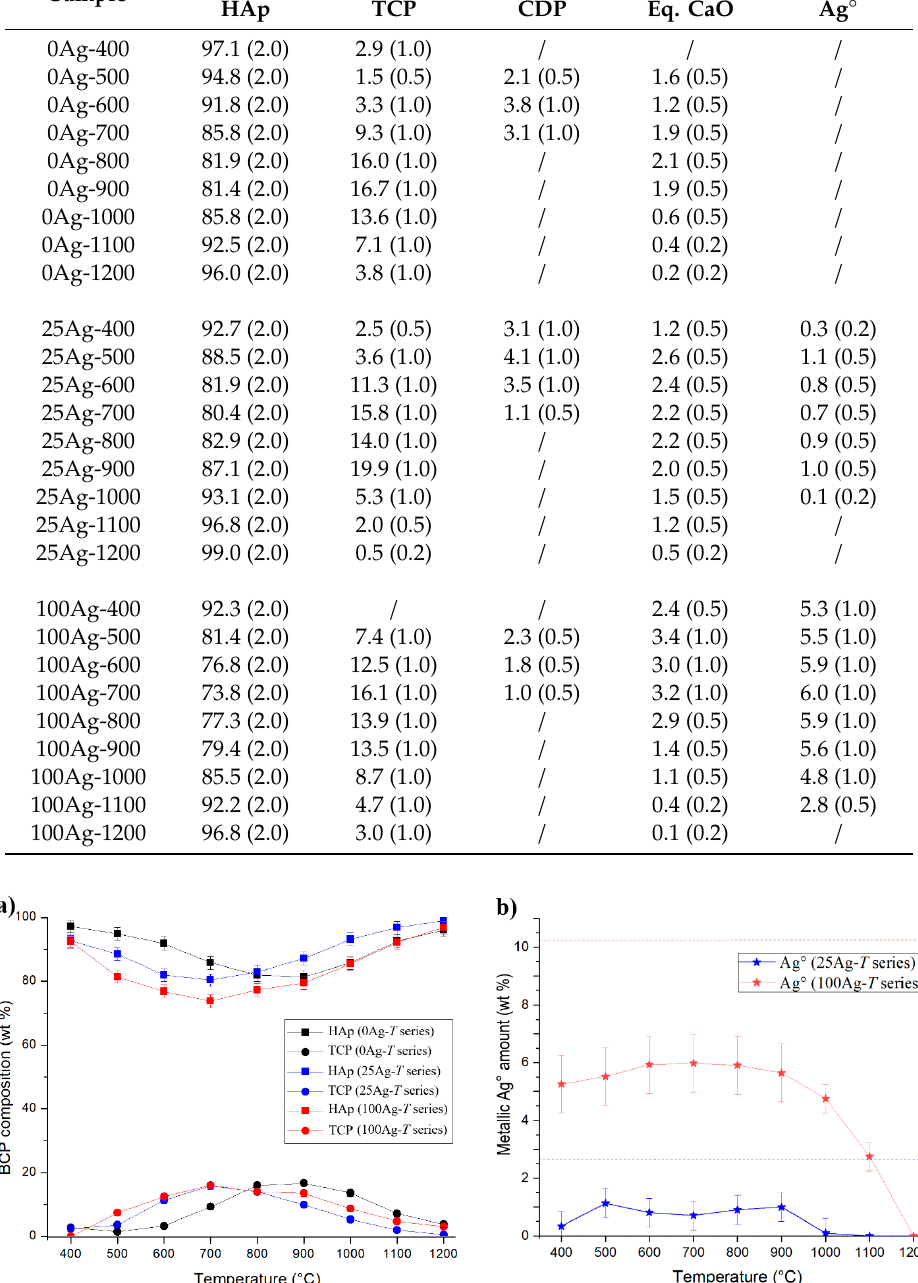
Figure 2. Thermal variation in ( a ) the two main phase contents (squares: HAp; circles: TCP) from the biphasic calcium phosphates (BCP) samples and ( b ) the metallic silver amount (stars) for the undoped 0Ag- T series (black symbols), the 25Ag- T series (blue symbols), and 100Ag- T series (red symbols). Dotted lines indicate the nominal silver amounts, and lines are only guides for the eyes.